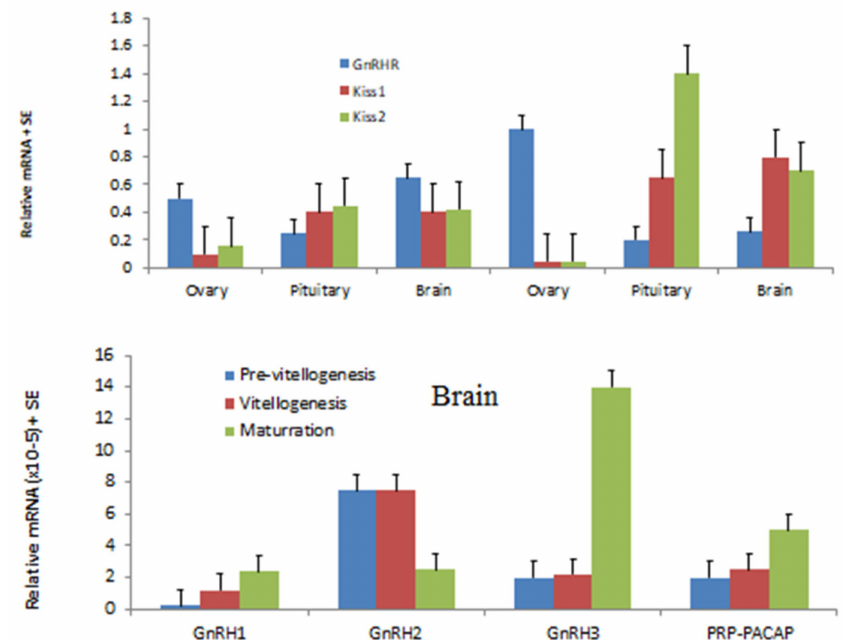
Figure 6. The relationship between the transcription of Kisspeptin (Kiss) 1 and 2 in the brain and the mRNA level of gonadotropin-releasing hormone (GnRH1, 2, 3), pituitary adenylate cyclase-activating polypeptide (PACAP) in various tissues of female blue gourami is presented